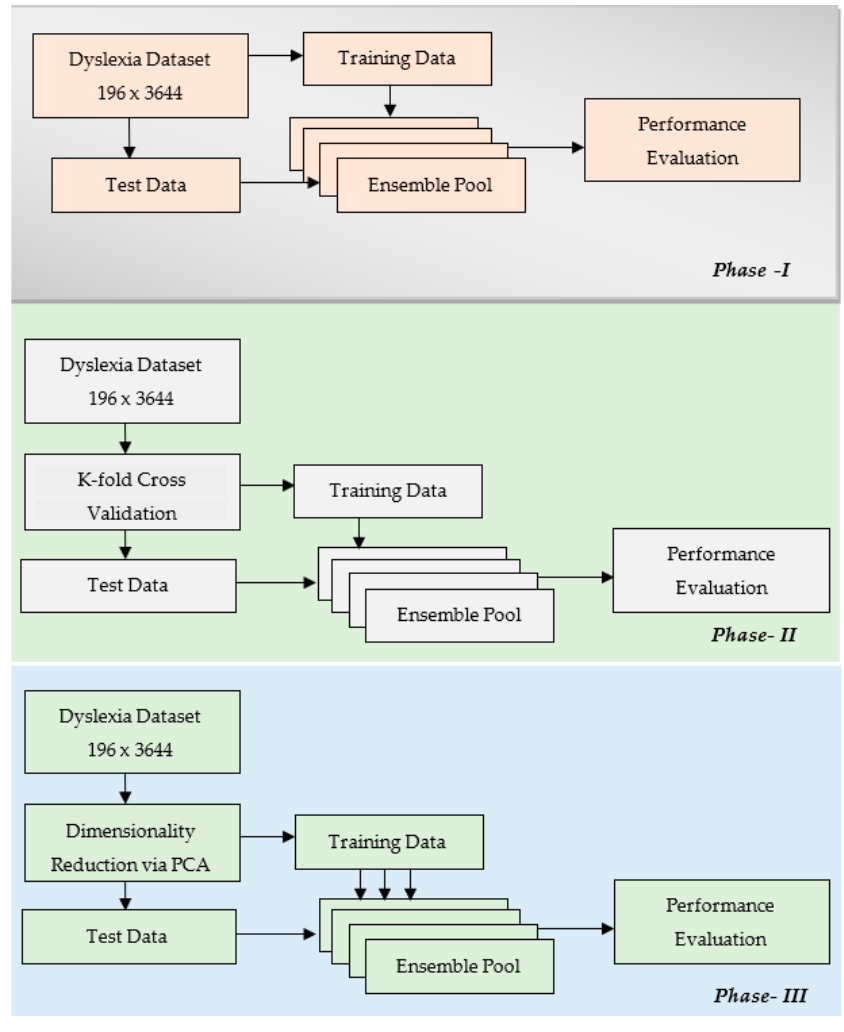
Figure 4. Schema for the proposed